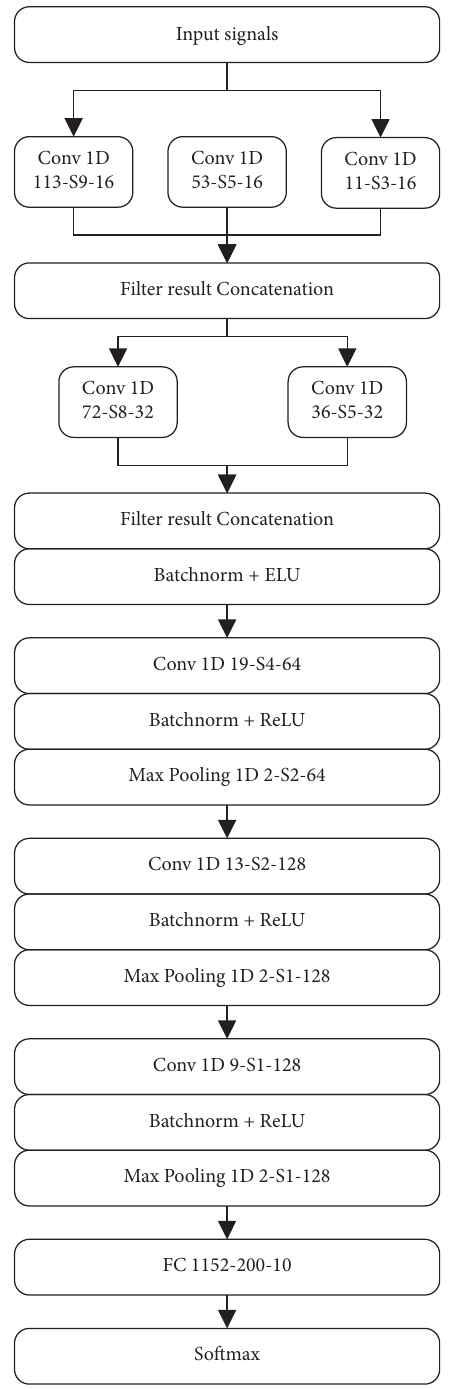
Figure 2: Architecture and parameters of